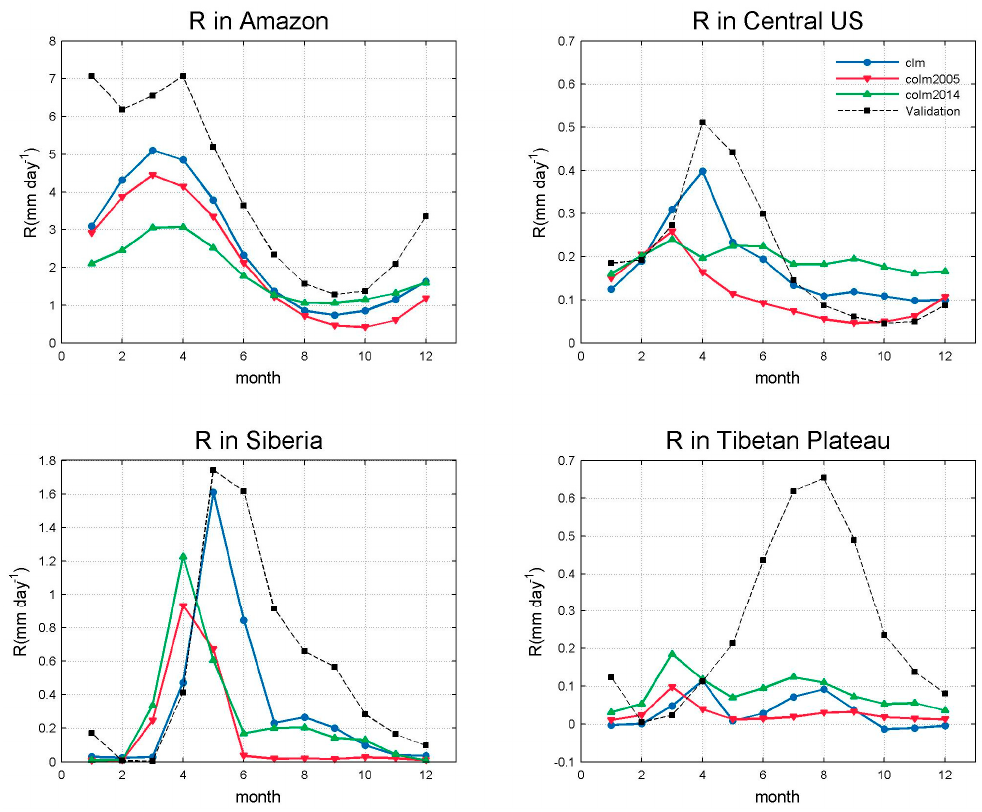
Figure 4. Annual cycles of simulated (colored lines) and observed (black dashed lines) runoff for the Amazon (10° S–0°, 70°–50° W), Central US (30°–50° N, 105°–90° W), Siberia (50°–66.5° N, 60°–140° E),